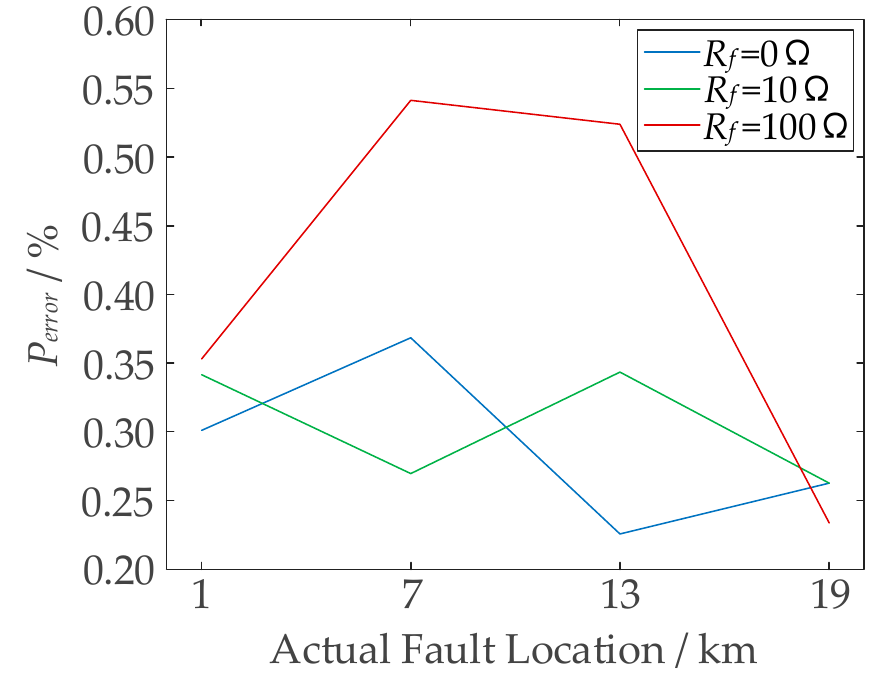
Figure 7. Simulation results for positive pole-to-ground short-circuit. As DC distribution lines are mostly cable lines and shorter in length than transmission lines, the fault resistance is small, generally not more than 10 Ω for pole-to- pole short-circuit and not more than 100 Ω for pole-to-ground short-circuit. As can be seen from the results in Table 1, the fault resistance has an impact on fault location accuracy, and the overall error increases when other influencing factors are controlled. However, even with a fault resistance of up to 10 Ω or 100 Ω , the accuracy of the proposed method can still be maintained within 0.6%. The maximum absolute error rate is 0.5415%, indicating that the fault location method proposed in this paper can quickly and accurately achieve fault location for the whole DC line under different fault conditions, and is quite resistant to fault resistance. 4.2. Influence of Sampling Frequency This fault location method based on the traveling wave principle is highly precise. However, the method itself needs a high sampling frequency, which may lead to large location errors at low sampling frequencies, while increasing the sampling frequency will necessarily result in increased equipment investment, which is currently one of the biggest limitations of the application of the traveling wave principle in distribution networks. The sampling frequencies were set at 10 kHz and 100 kHz, and the results of the proposed method to verify the fault location under positive pole-to-ground fault are shown in Figures 8 and 9, and in Table 2. Table 2. Fault location results for different sampling frequencies. x (actual) /km